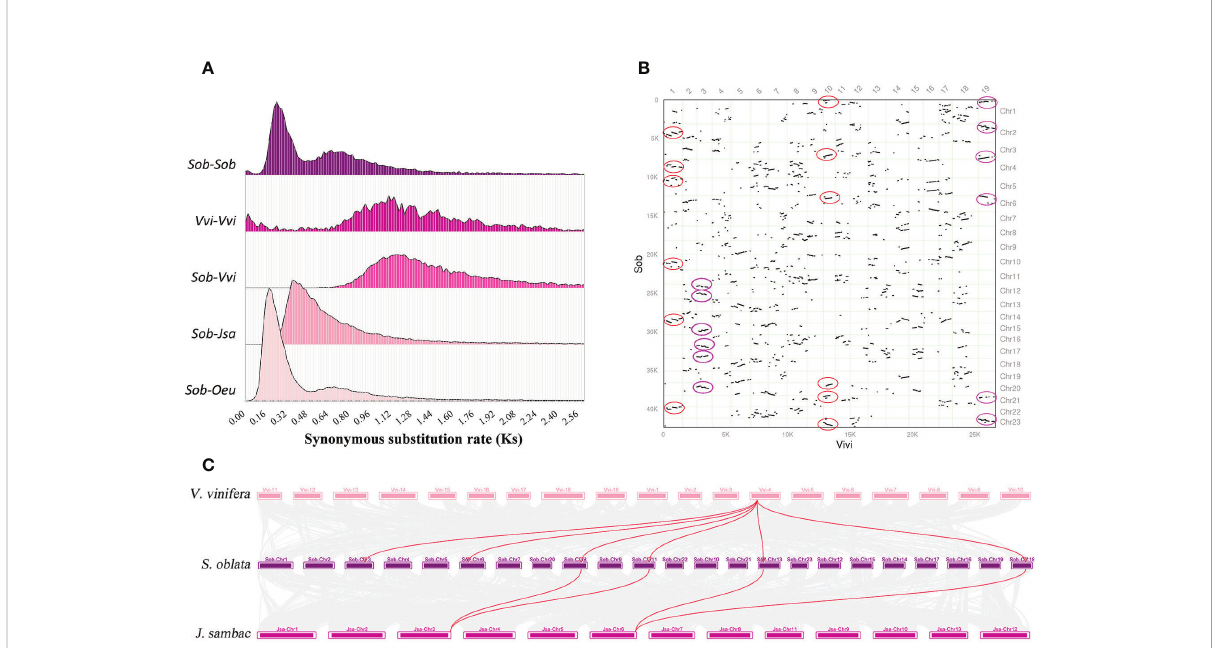
FIGURE 3 The genome-wide duplication events of S. oblata . (A) Ks density pro fi les of S. oblata, V. vinifera and S. oblata versus J. sambac, V. vinifera and O. europaea . (Sob : S. oblata,Vvi : V. vinifera, Jsa : J. sambac, Oeu : O. europaea) (B) Pairwise synteny visualization of V. vinifera versus S. oblata . (C) Karyotype map of the genomes of S. oblata, J. sambac and V. vinifera .